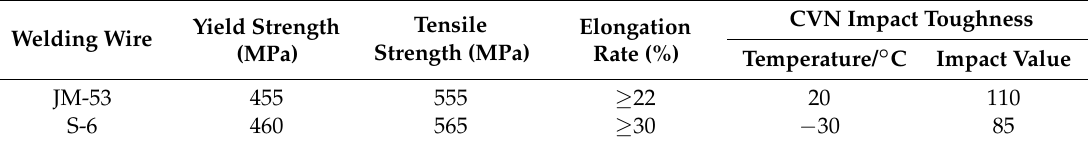
Table 4. Mechanical properties of weld wire JM-53 and S-6.